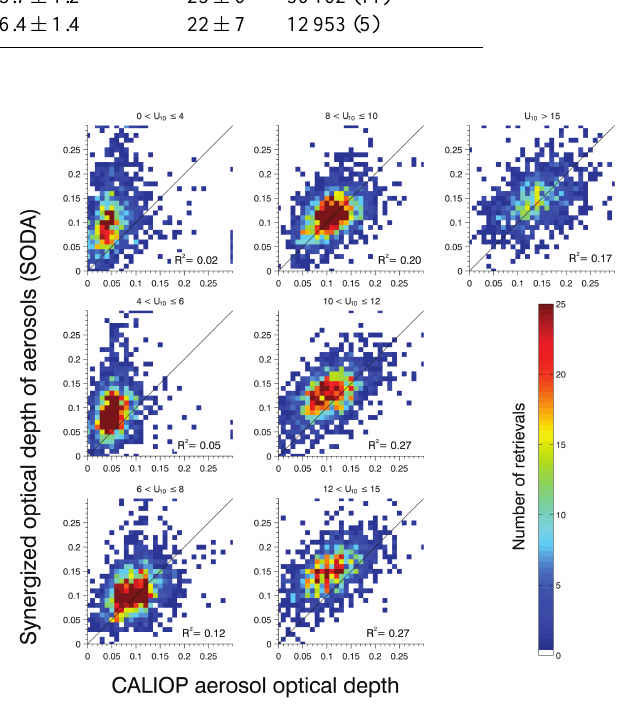
Figure 4. Scatter density plot of SODA to CALIOP AOD for each wind speed regime. Each point indicates a grid cell median, colored by frequency of occurrence. The black line is the 1:1 relationship, with reported R 2